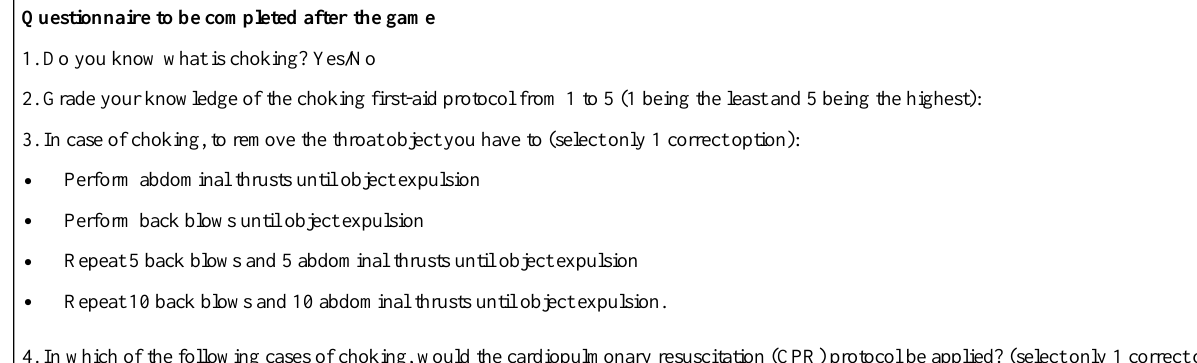
Textbox 2. Test 2 questionnaire after playing the